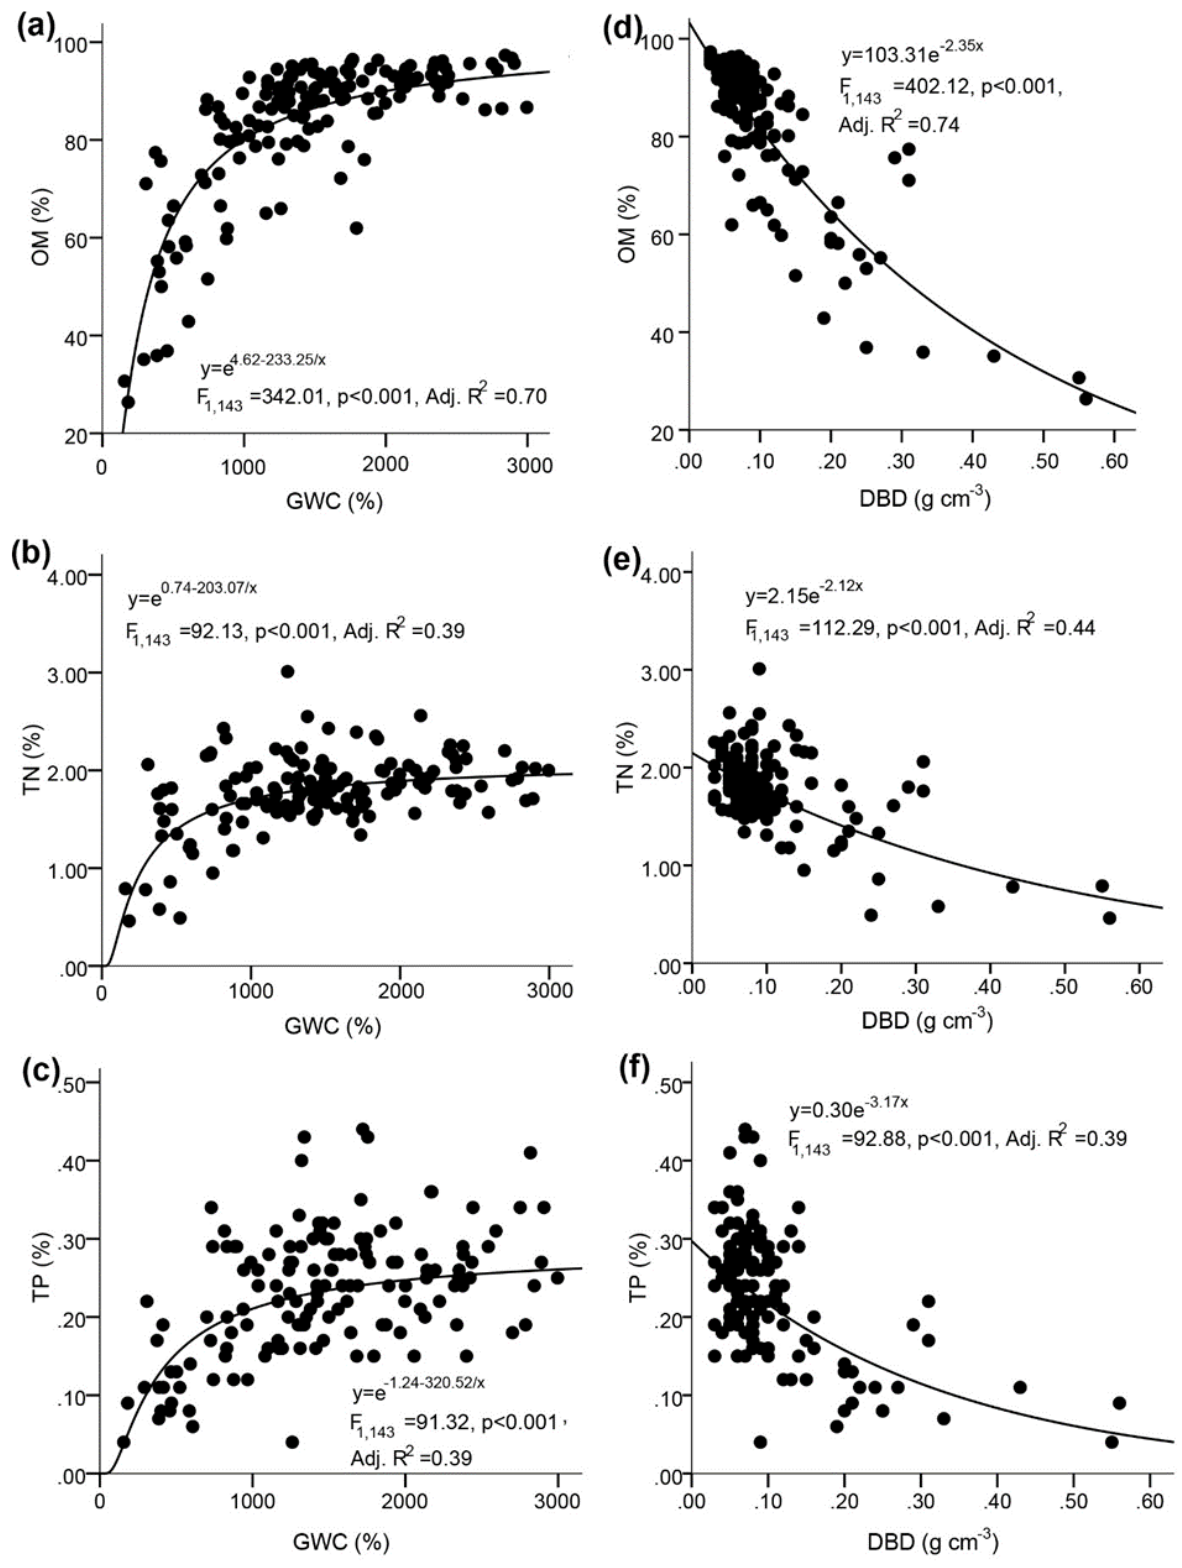
Figure 5. The relationships between (a) gravimetric water content (GWC) and organic matter (OM), (b) gravimetric water content (GWC) and total nitrogen (TN), (c) gravimetric water content (GWC) and total phosphorus (TP), (d) dry bulk density (DBD) and organic matter (OM), (e) dry bulk density (DBD) and total nitrogen (TN), (f) dry bulk density (DBD) and total phosphorus (TP). The significant regression lines and their equations, R 2 , F and p-values are